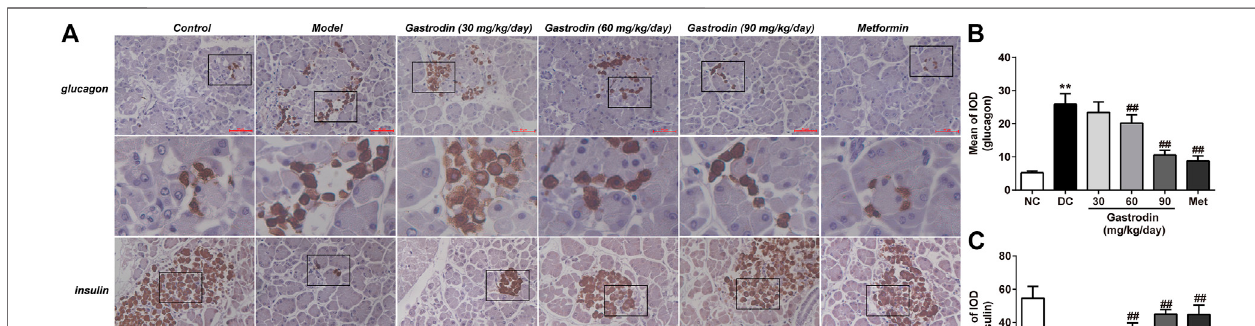
Frontiers in Pharmacology |